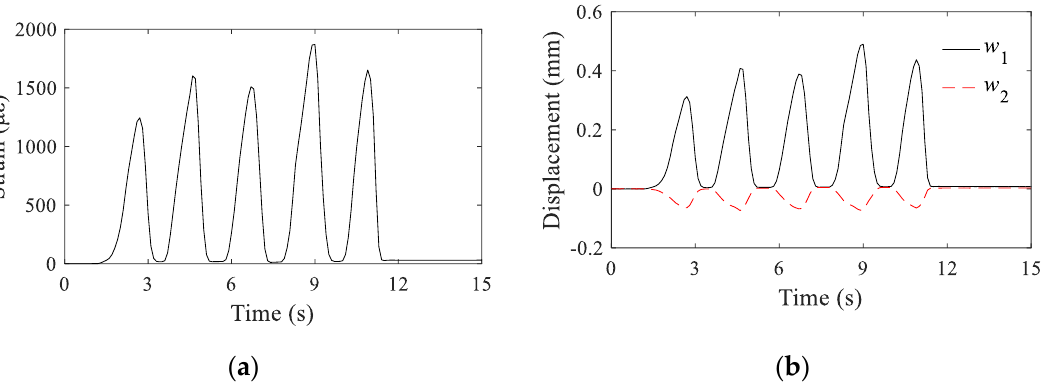
Figure 7. Strain and displacement curves under repeated load ( a ) strain curve; ( b ) displacement curve.